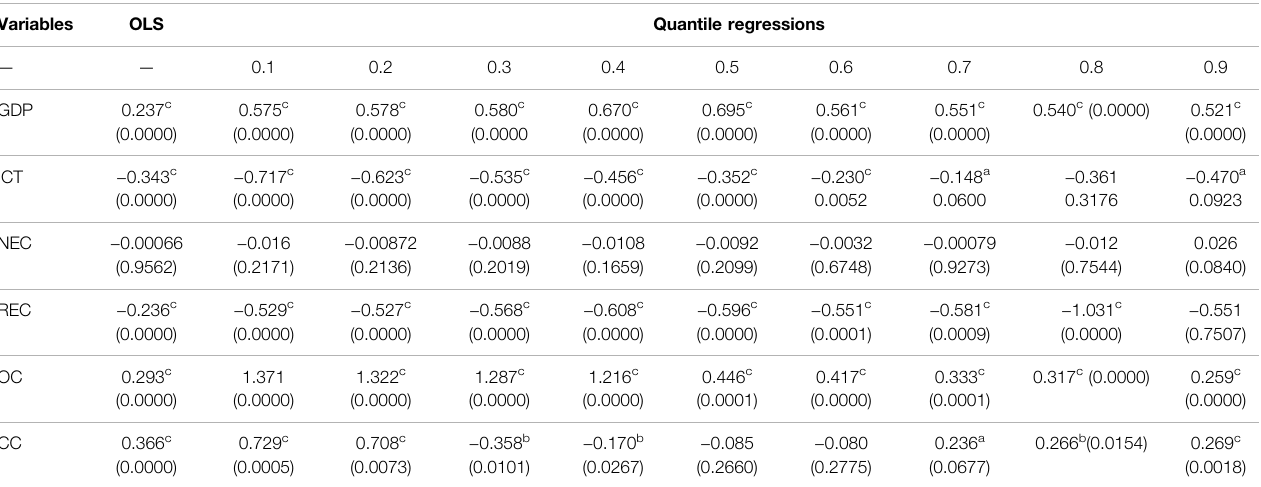
TABLE 6 | Panel Quantile Regression